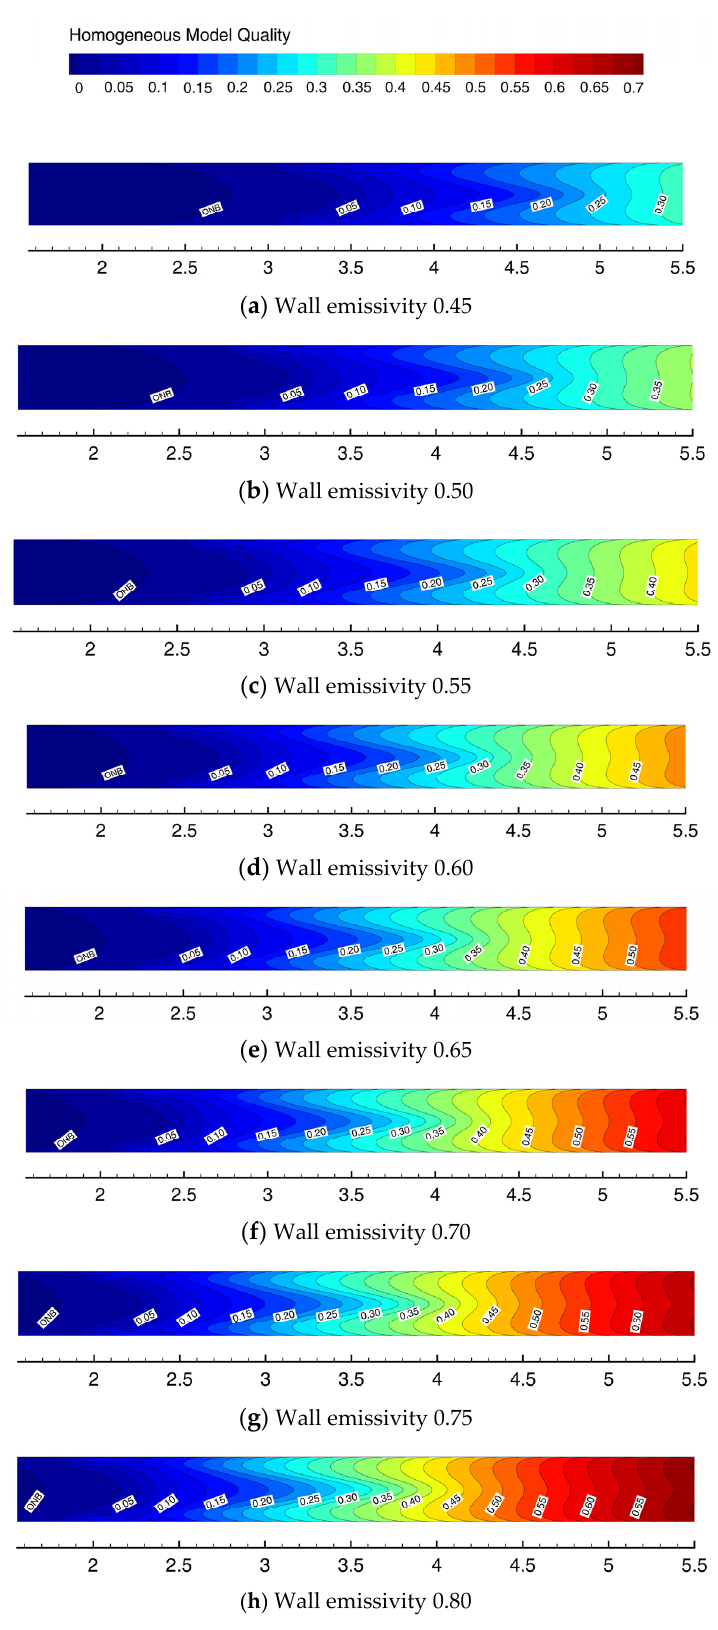
Figure 14. Homogeneous model quality distributions under wall emissivity ranging from 0.40 to 0.80.